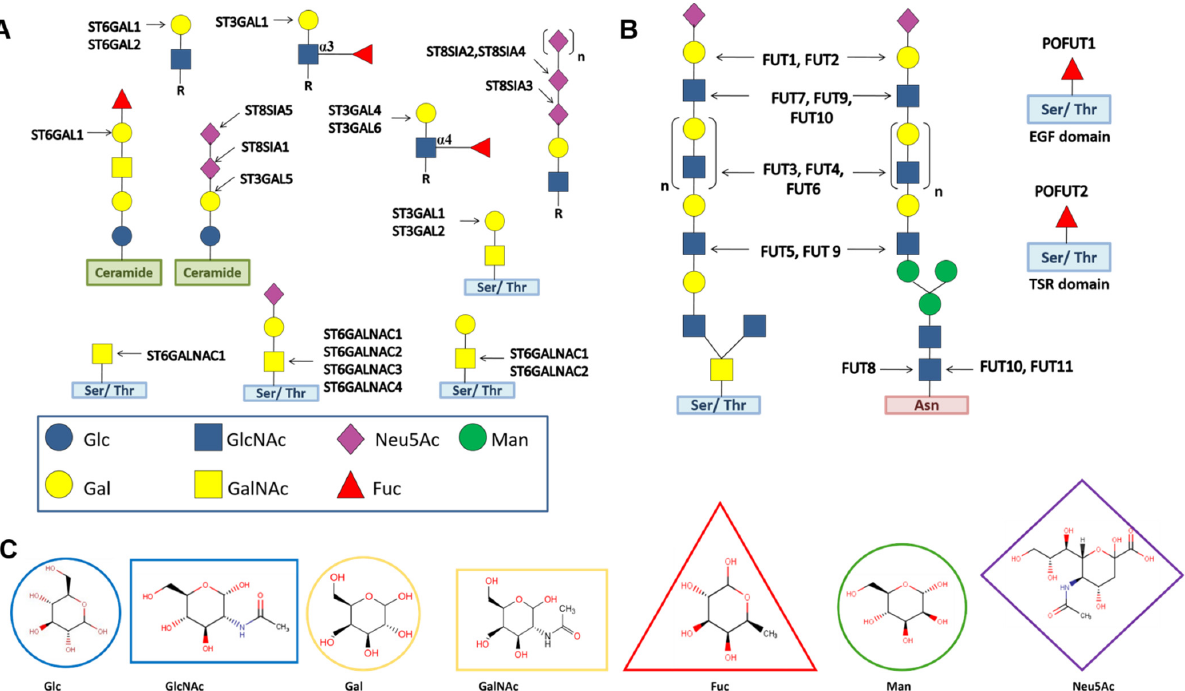
Figure 1. Sialylation and fucosylation sites of human STs and FUTs. ( A ) Sialylation site for STs including ST3GAL; ST6GAL; ST6GALNAC; and ST8SIA, which generates sialylated-tumor-associated carbohydrate antigens; ( B ) fucosylation site of human FUTs including α ,2 FUT; α 1,3/4 FUT; α 1,6 FUT; and O-FUT. STs and FUTs transfer Neu5Ac and Fuc, respectively, to different monosaccharide residues of O -glycans; N -glycans; EGF or TSR domains of proteins, e.g., Notch and thrombospondin 1; and glycolipids, as indicated by the arrows. Abbreviations: Glc: D-Glucose; Gal: D-Galactose; GlcNAc: N -Acetyl-D-glucosamine; GalNAc: N -Acetyl-D-galactosamine); Fuc: L-Fucose; Man: D-Mannose; Neu5Ac: N -Acetyl-D- neuraminic acid (or sialic acid); Ser/Thr: serine/threonine; Asn: asparagine; EGF: epidermal-growth-factor-like repeat; and TSR: thrombospondin type 1 repeat. R represents N- or O- glycoproteins or glycolipids. ( C ) Structural representation of the monosaccharide residues present in glycans.